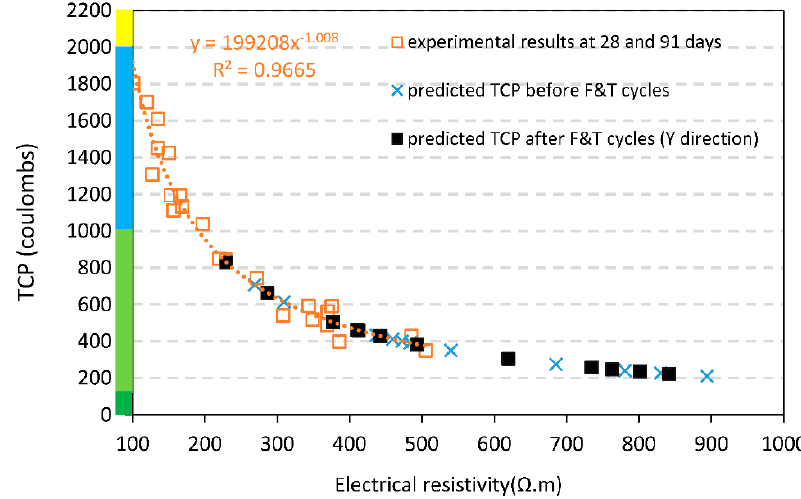
Figure 16. Estimation of total charge passed based on experimental results and equation obtained from last technical paper [40].